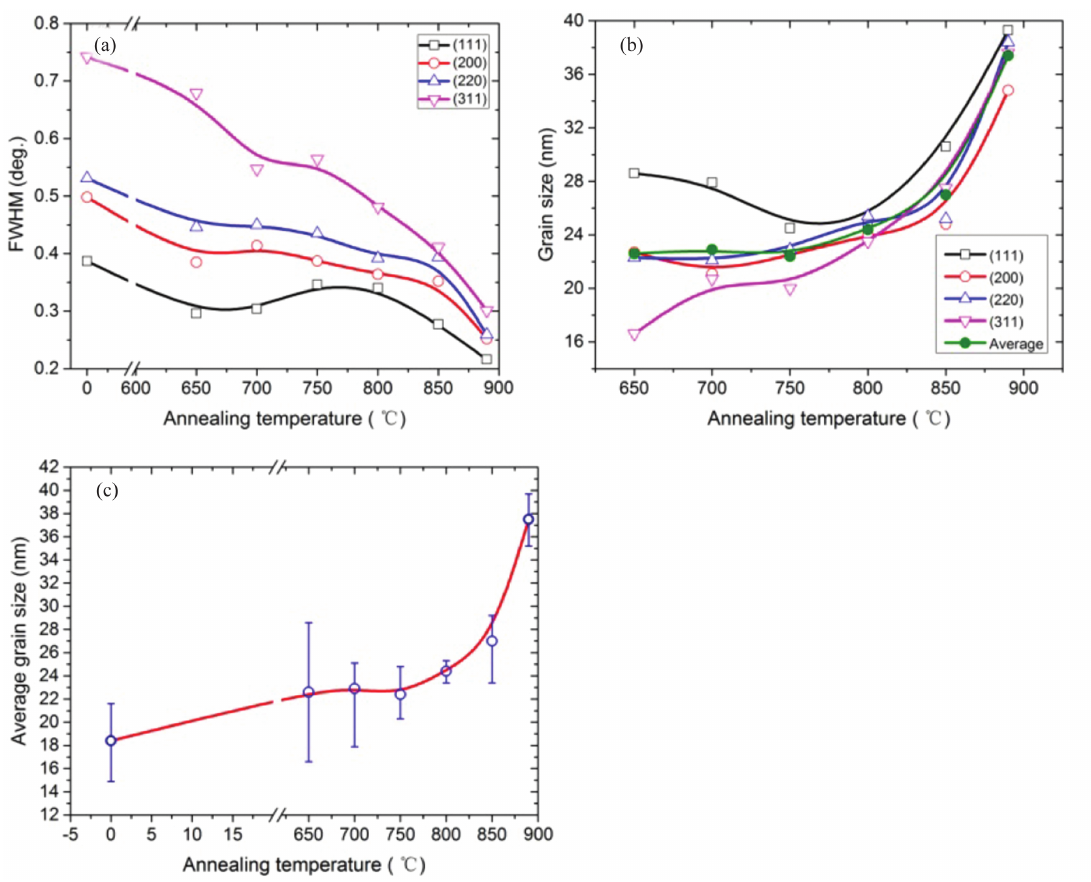
Figure 11: FWHM and grain sizes of the deformed specimen as a function of annealing